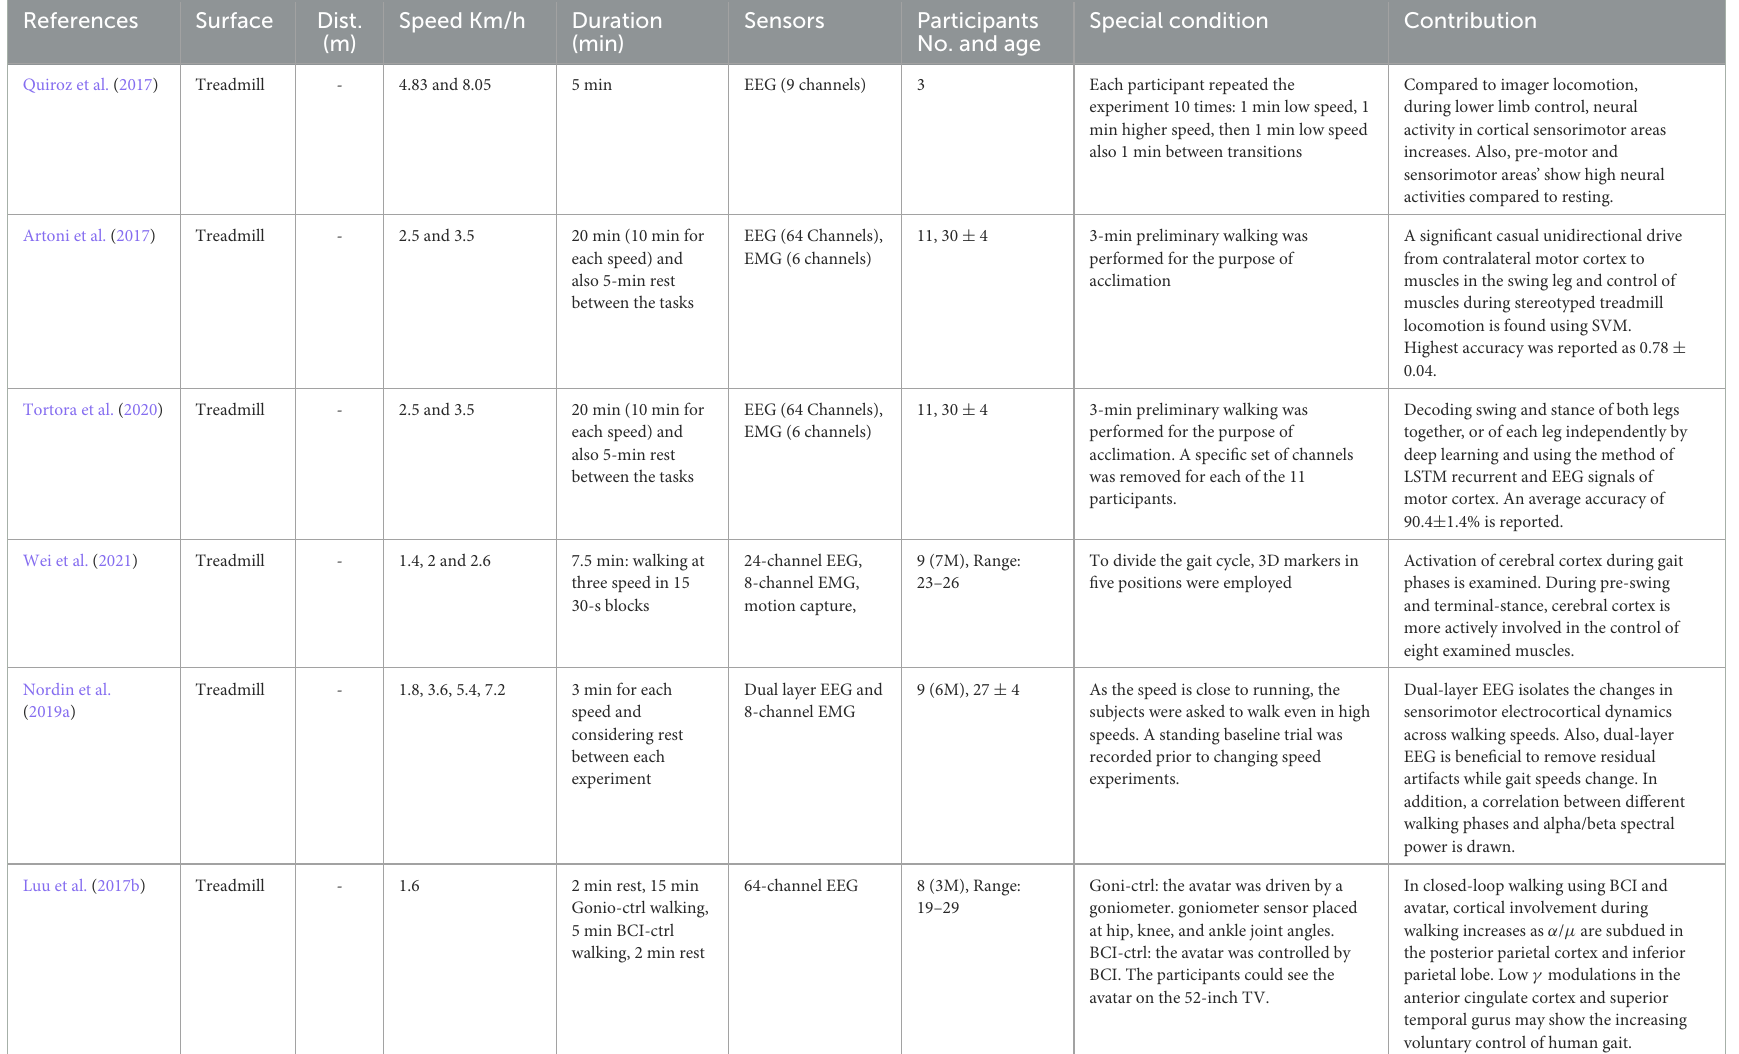
Each participant repeated the experiment 10 times: 1 min low speed, 1 min higher speed, then 1 min low speed also 1 min between